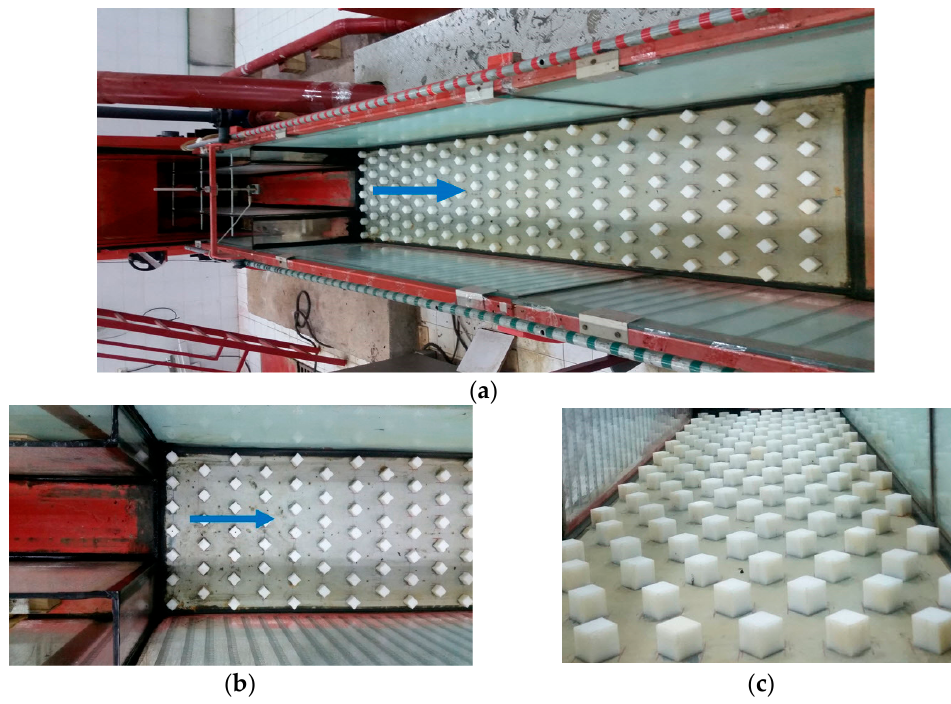
Figure 4. ( a ) Sketch for asymmetric expansion geometry of 𝛼 = 0.5 and roughness elements with lozenge shape. ( b ) Plan view of abrupt asymmetry with expansion ratio of 𝛼 = 0.5. ( c ) Arrangement of roughness elements with height of h = 2.8 cm.